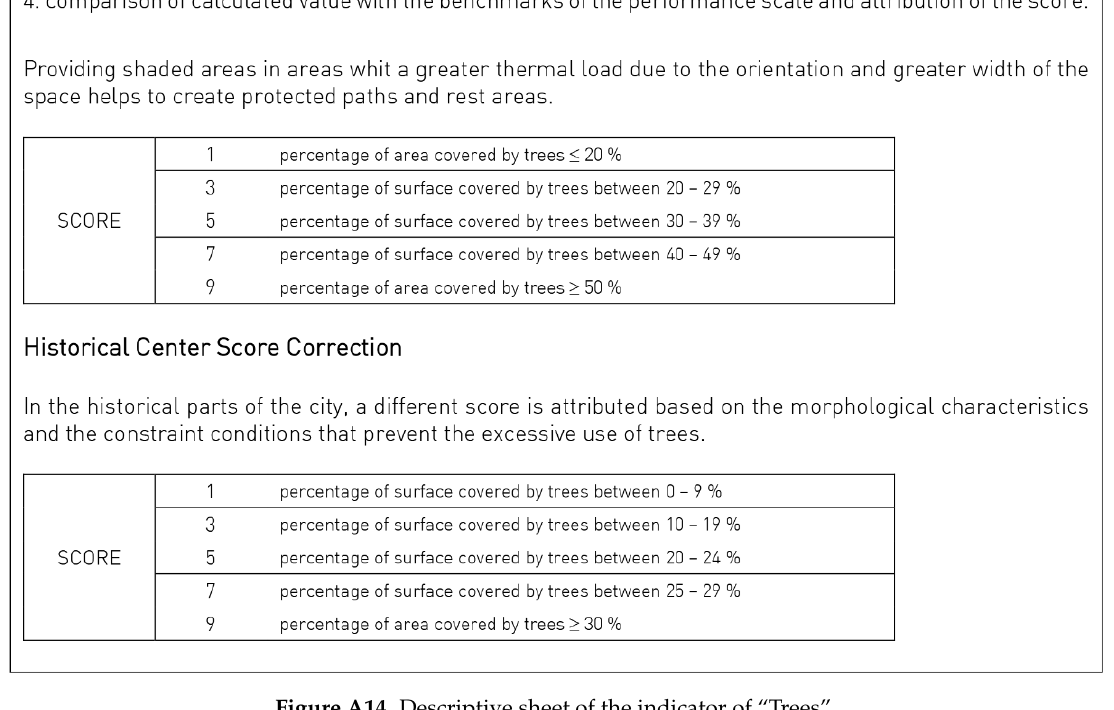
Figure A14. Descriptive sheet of the indicator of “Trees”.